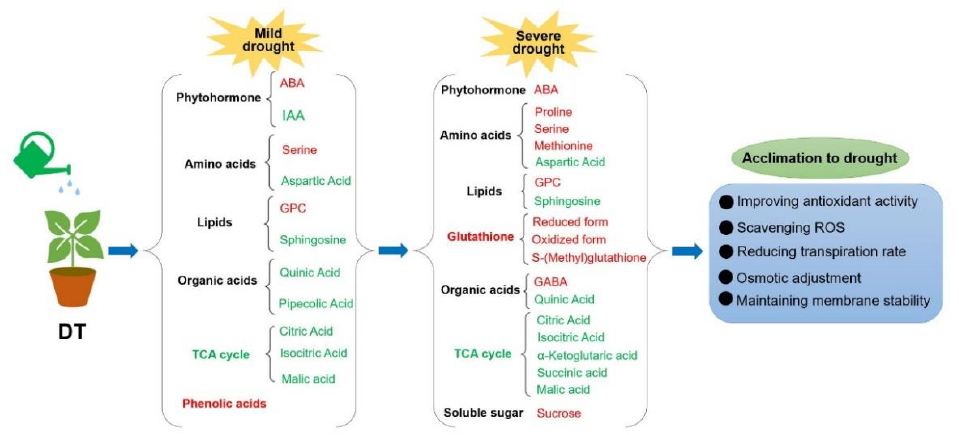
Figure 9. The outline of drought − tolerant genotype responses to drought stress. The red represents increased, while the green represents decreased. ABA, abscisic acid; IAA, indole 3 − acetic acid; GPC, choline alfoscerate; TCA cycle, citrate cycle; GABA, γ−aminobutyric acid ; ROS, reactive oxygen species.